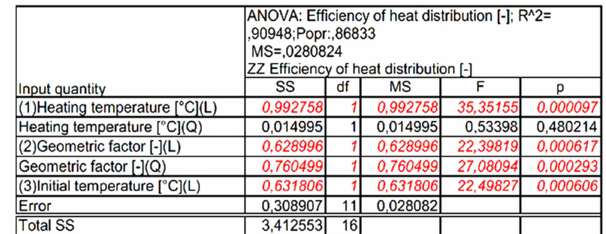
Figure 20. Summary of the results of the ANOVA analysis of the input variables on the value of the output variable, excluding insignificant quantities.